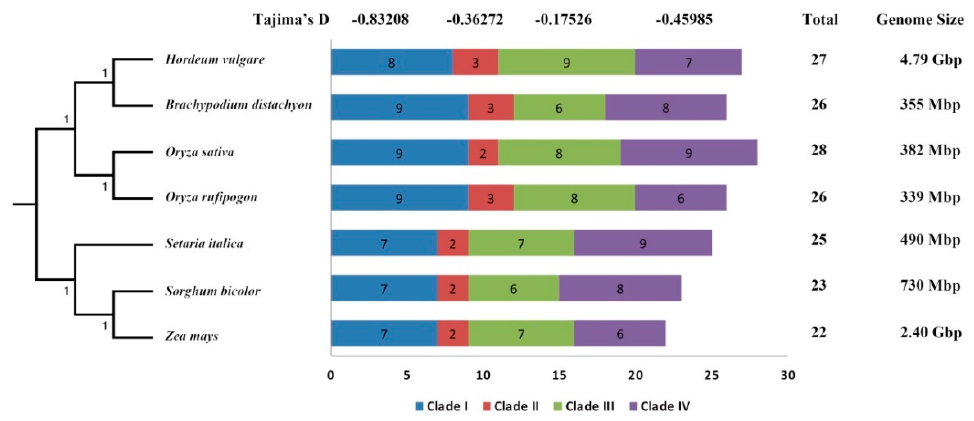
Figure 2. The STP gene numbers and Tajima’s values of four clades among seven species, including H. vulgare , B. distachyon , O. sativa ssp. japonica , O. rufipogon , S. italica , S. bicolor , and Z. mays . Table 1. Ka/Ks values and the divergence time of duplicate gene pairs in seven tested species.